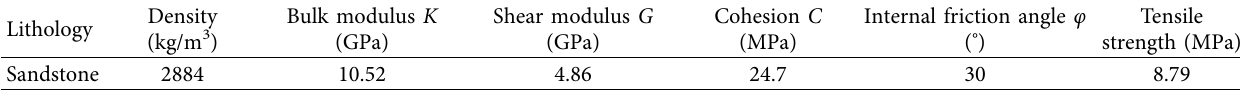
Table 1: Mechanical parameters of the rock.